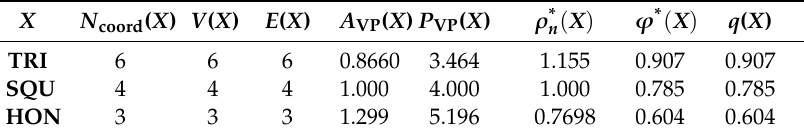
Table 8. Statistics of the Voronoi polygon of perfect, reference 2-D crystal X : coordination number N coord ( X ), number of vertices V ( X ) and edges E ( X ), surface area A VP ( X ), perimeter P VP ( X ), local